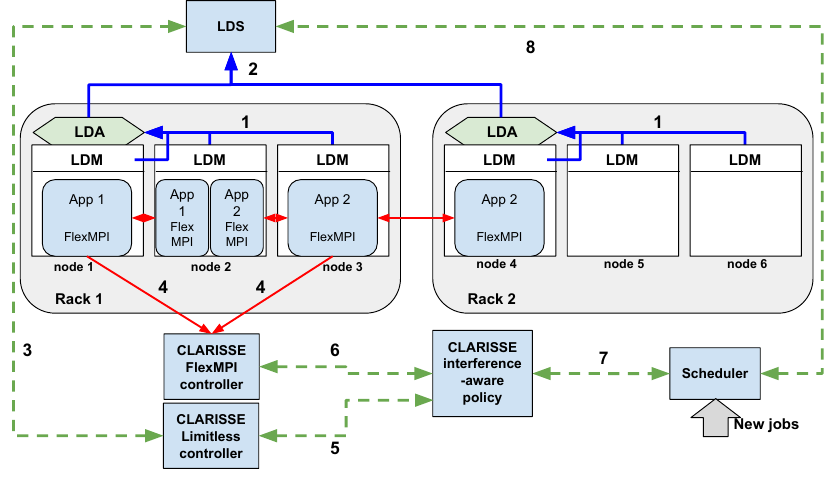
Figure 2. System